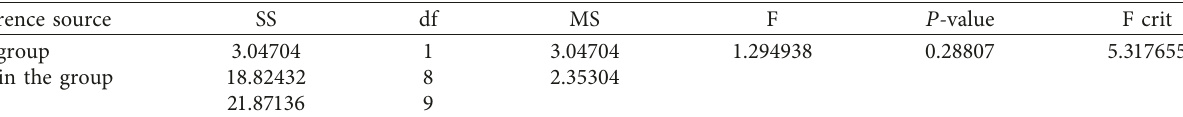
Table 9: Single factor variance analysis of oil-stone ratio and parameter A.